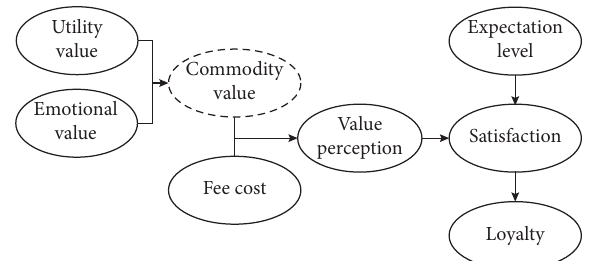
Figure 1: Path of the intrinsic mechanism of customer loyalty to goods.